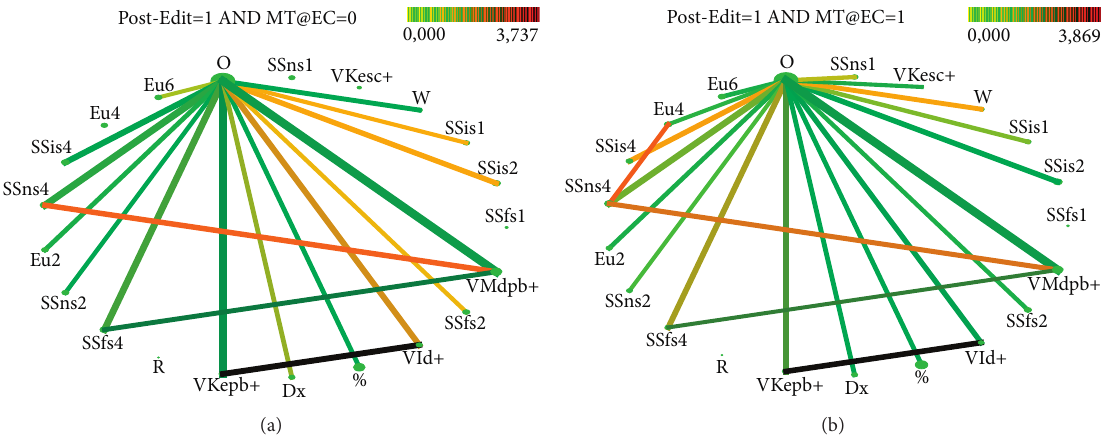
Figure 3: Visualization of tags identified in PEMT output translated by GT (a) and MT@EC